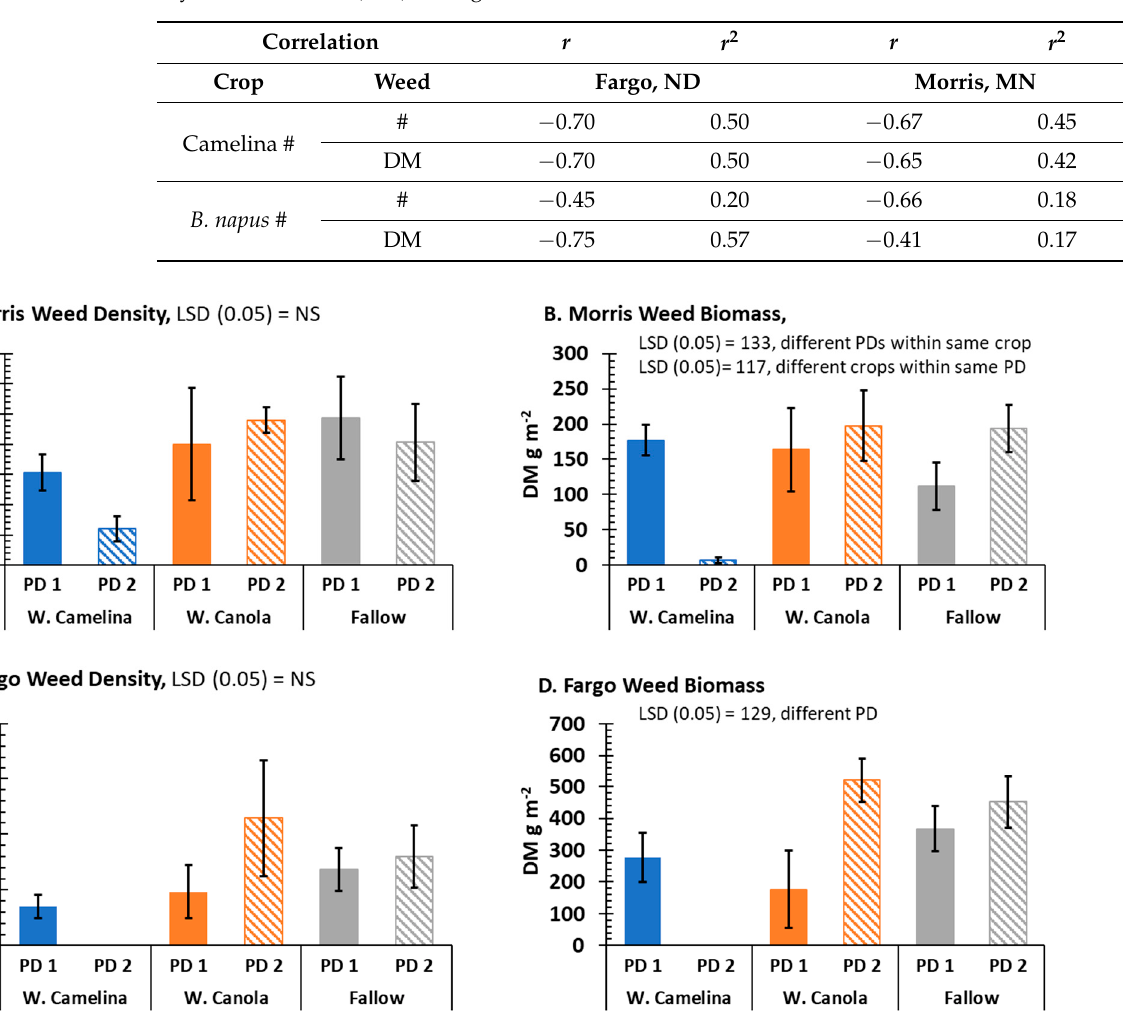
Figure 3. Weed density in crop [winter camelina, winter canola/rapeseed (W. Canola)] vs. fallow weed density ( A , C ) or weed dry matter (DM) biomass in crop [winter camelina, winter canola/rapeseed (W. Canola)] vs. fallow weed DM biomass ( B , D ) at Morris, MN ( A , B ) and Fargo, ND ( C , D ) based on crop planting date 1 (PD1 = late August 2019) or PD2 (mid − September 2019). Bars represent the mean ±